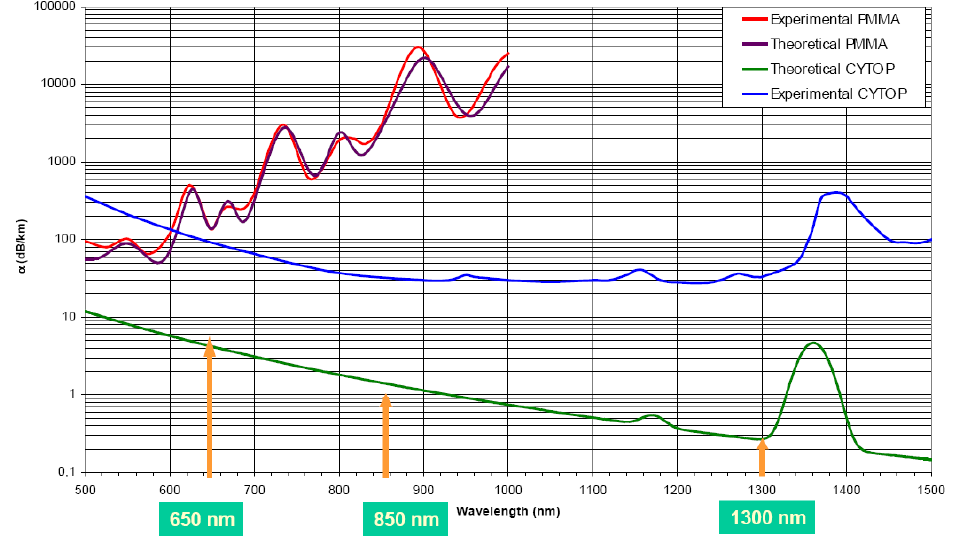
Figure 3. Spectral attenuation of the graded index POF as compared to glass fiber [7].